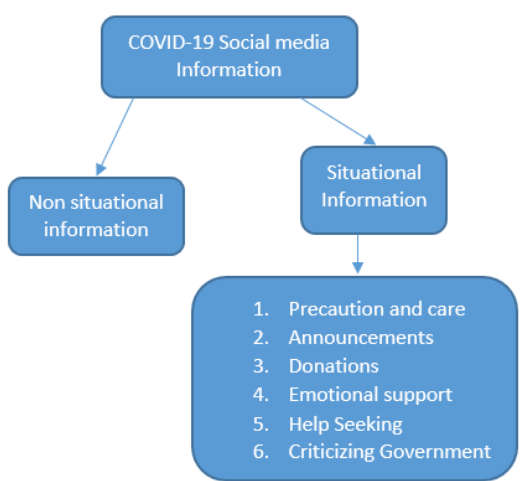
Figure 1. COVID-19 situational information on